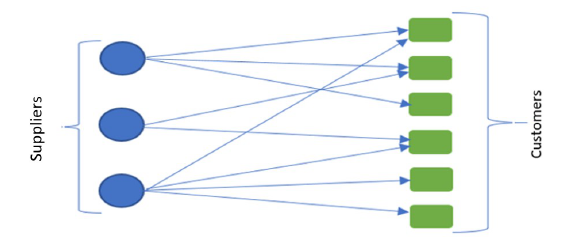
Fig. 2. Basic distribution of the products